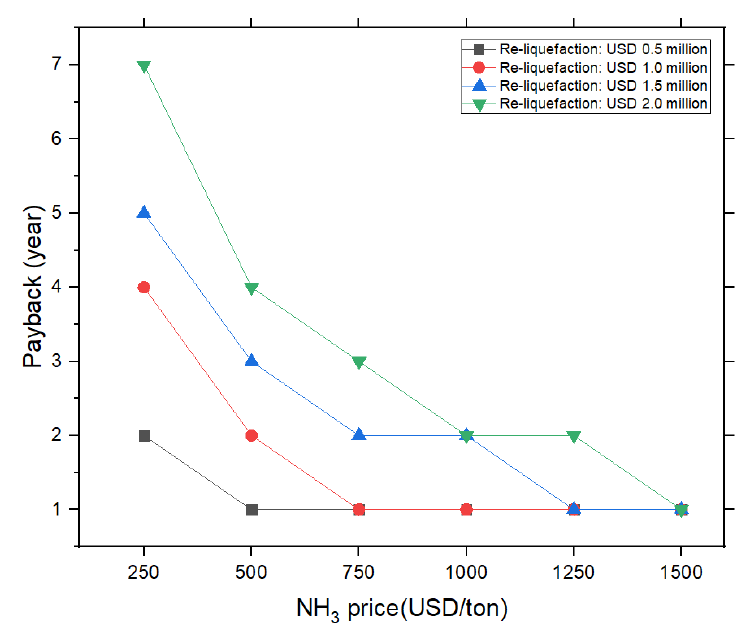
Figure 6. Payback for the NH 3 and re-liquefaction prices. Figure 7 describes NPVs for the fuel and re-liquefaction system price. The NPV is positive when the re-liquefaction system price is less than USD 1.5 million and negative when the re-liquefaction system price is USD 2 million and the ammonia price is USD 250/ton.